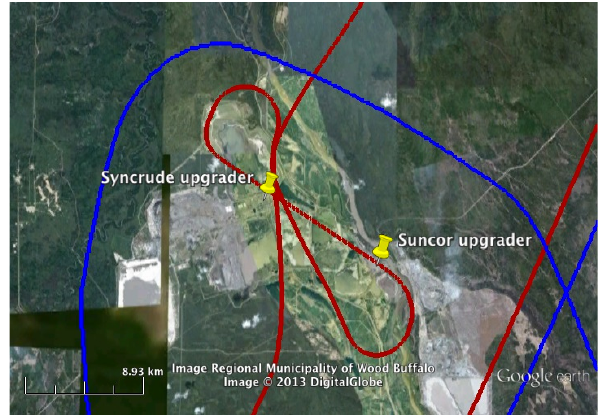
20 Figure 1. Imagery of the oil sands region from 29 June and flight tracks from 10 July. The DC-8 track is blue; the P3B red. The two planes entered the area from the north along the parallel tracks to the right. The DC-8 then looped counterclockwise around the facilities at about 350ma.g.l; 90 min later the P-3B approached from the south and flew the figure 8 shown, penetrating the Syncrude facility plume three times, twice at about 250ma.g.l. and once at 600m. The Suncor upgrader plume was sampled once, at